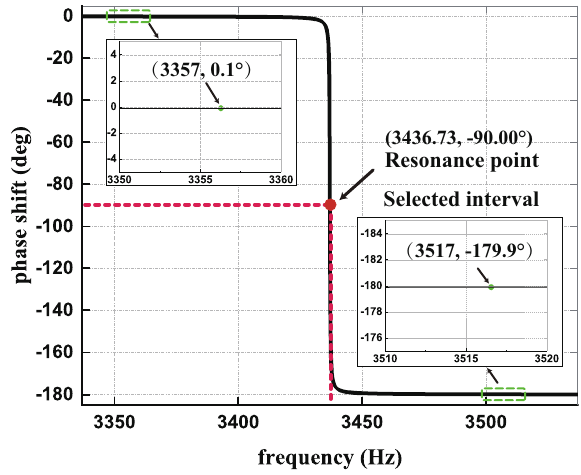
Figure 7. The P-F characteristic of the gyroscope